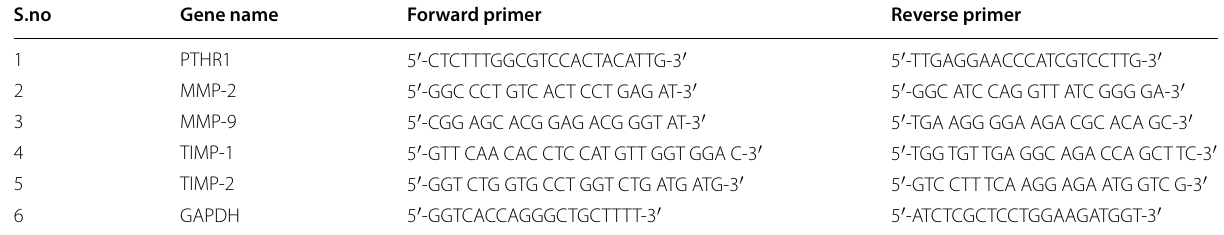
Table 1 List of RT-PCR primers used in this study S.no Gene name Forward primer